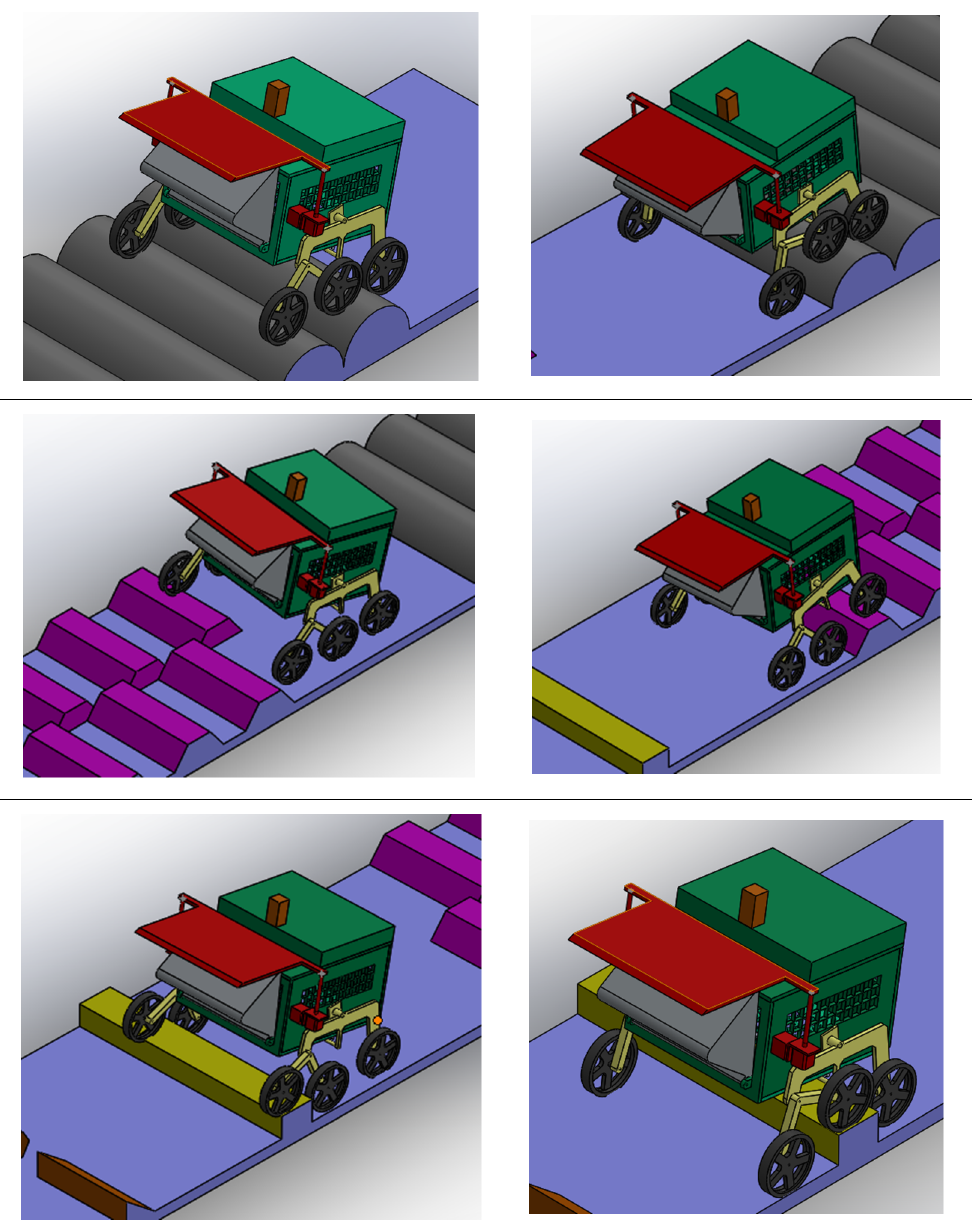
Table 2. Testing the robot on different terrain.